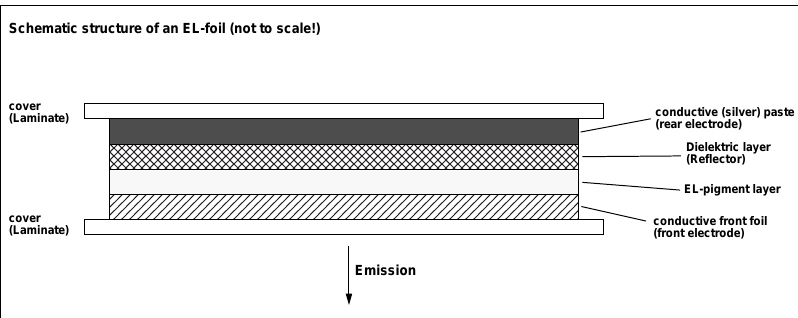
Figure 1 . Internal structure (schematic) of an AC-EL foil lamp. Schematic structure of an EL-foil (not to